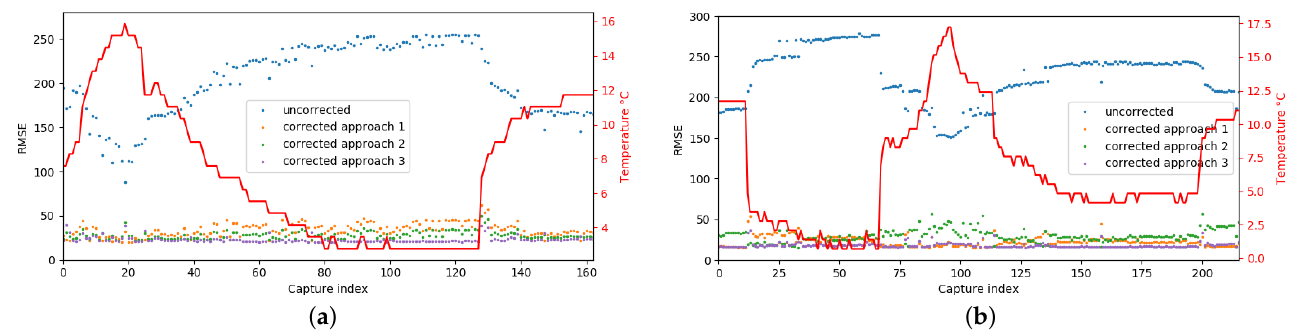
Figure 9. The RMSE before and after applying the correction model to the samples obtained from the testing scenario for ( a ) experiment 1 and ( b ) experiment 2. The red plot corresponds to the temperature values, the blue one to the original depth values and the orange, green and violet plots to the corrected depth values using the three approaches to model the error based on camera parameters (approach 1), global model equation (approach 2) and recomputed camera parameters (approach 3),